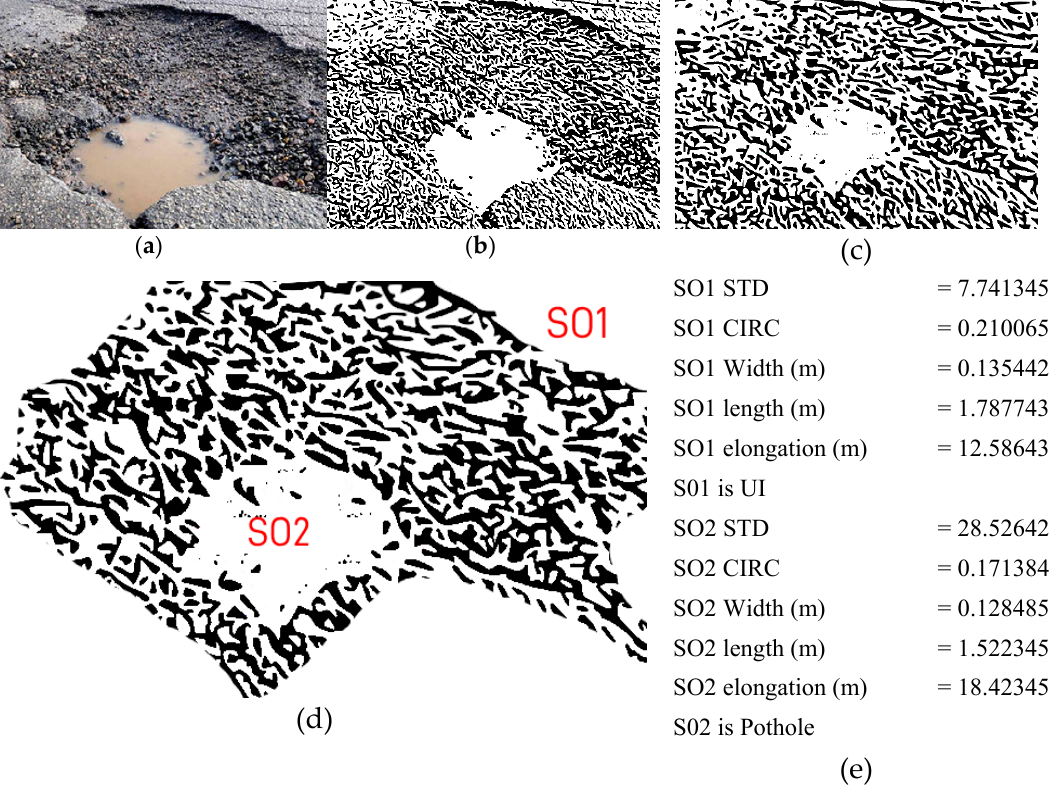
Figure 5. Procedure to categorize the image using the proposed method: ( a ) original image; ( b ) processed image; ( c ) further processed image; ( d ) image after Hanuman algorithm; ( e ) report of the Hanuman algorithm.